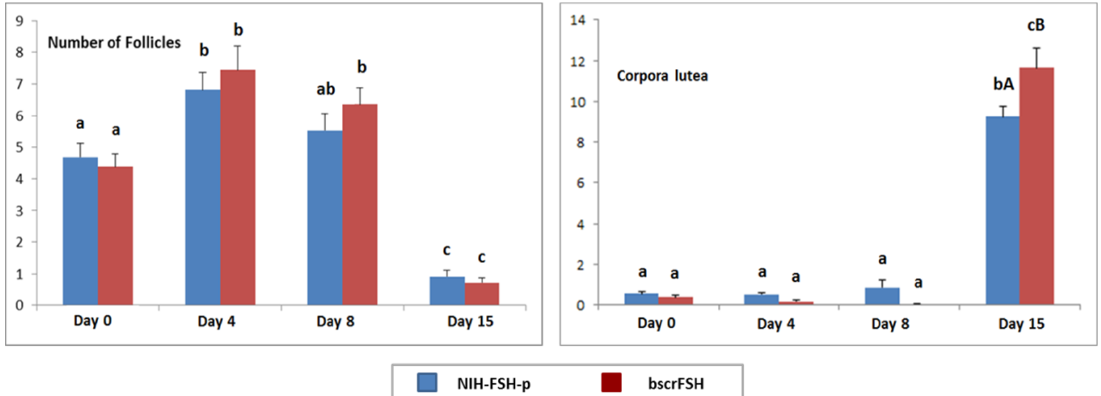
Figure 3. Ovarian structures (follicles and corpora lutea) over time; NIH-FSH-p vs. bscrFSH SOV protocol. The results are presented as Mean ± S.E.M. Bars (Mean ± S.E.M.) with different superscripts (a–c) denote statistically significant differences between time-points (days) ( p < 0.05). Values (Mean ± S.E.M.) with different superscript letters (A,B) within each time-point (day) are significantly different between SOV protocols ( p < 0.05). Unit: ng/mL.